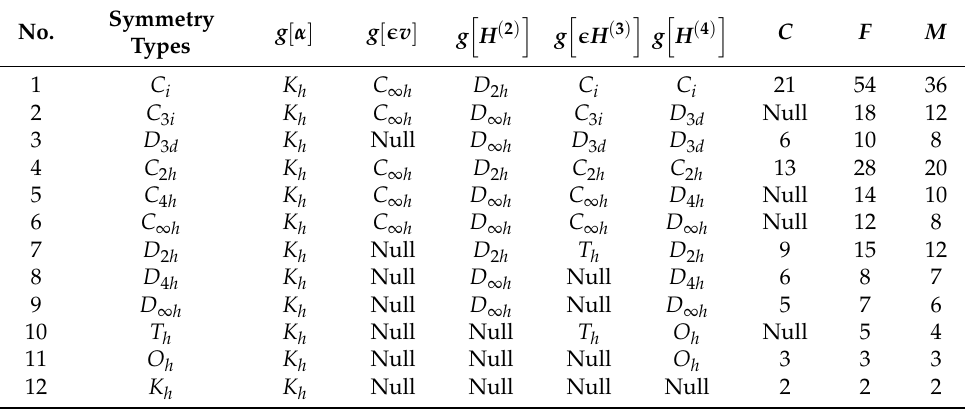
Table A1. Symmetry types and distinct components of fourth-order